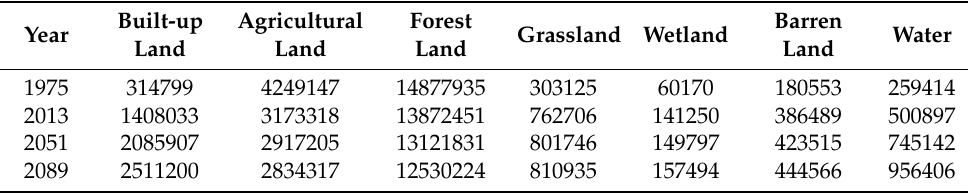
Table 2. Total land demand